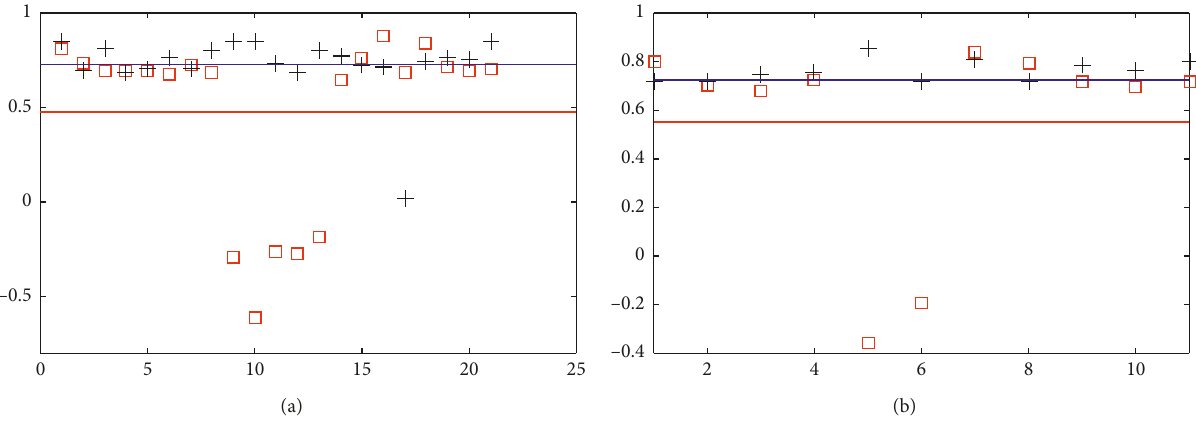
Figure 15: Analyzed cases of vector length: (a) version order of AR � 4, order of MA � 3; (b) version order of AR � 4, order of MA � 3.